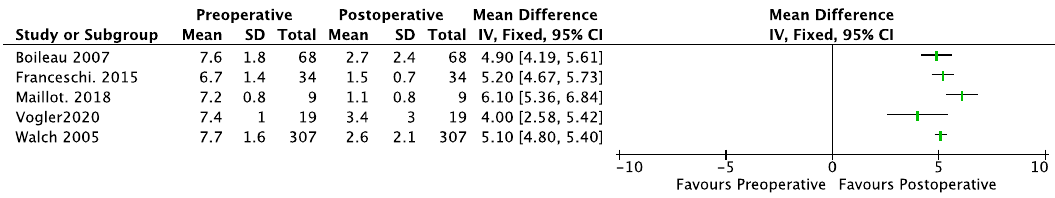
Figure 6. Forest plot of comparison: VAS, outcome in BT. SD: Standard Deviation.